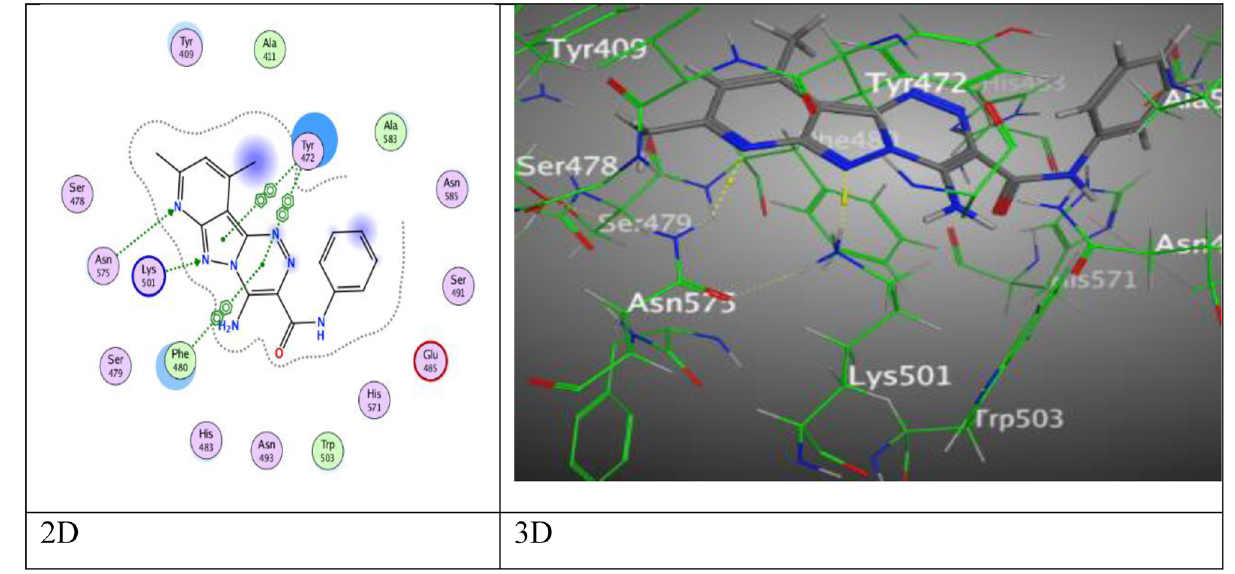
Figure 8. The binding interactions of compound 3a with active sites of (PDB ID: 5IVE).